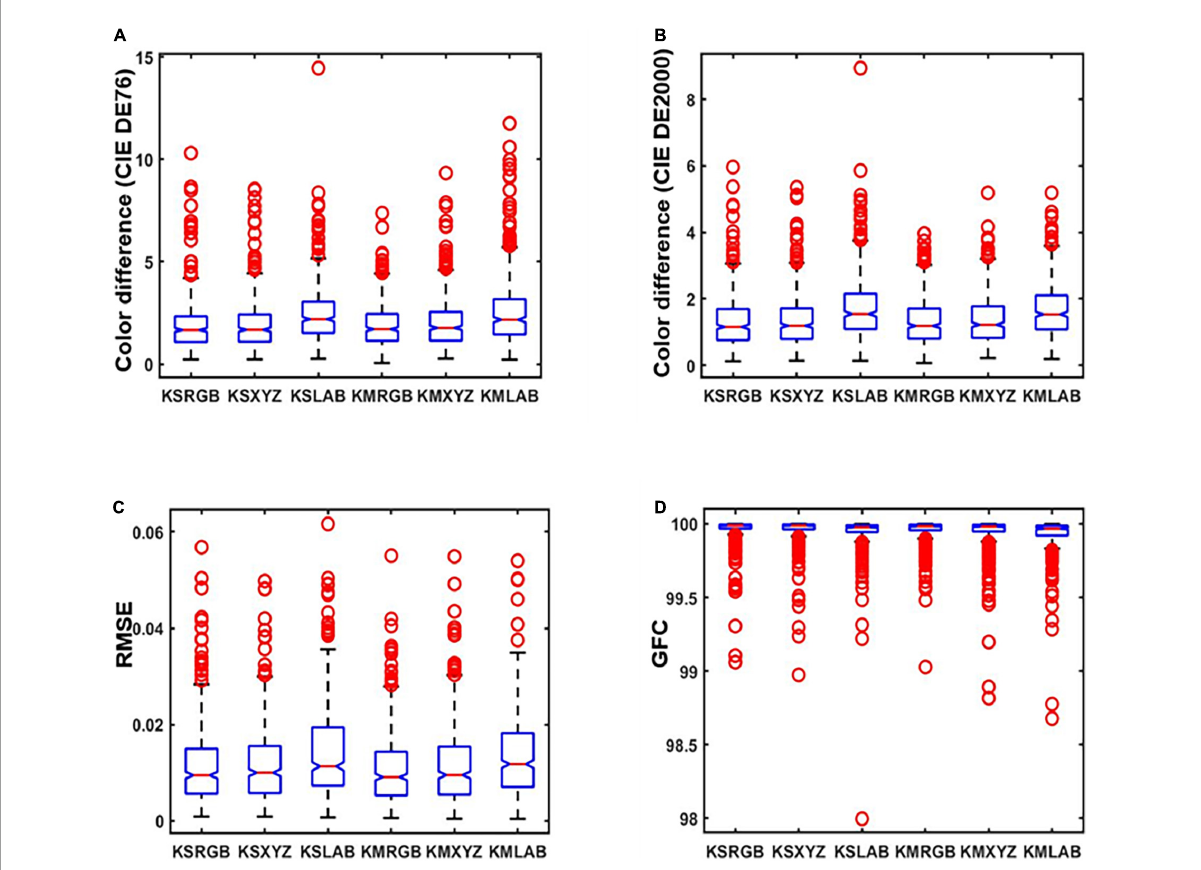
FIGURE10 Boxplots of results in different color spaces: (A) The International Commission on Illumination (CIE) DE1976 color difference, (B) CIE DE2000 color difference, (C) root-mean-square error (RMSE), and (D) goodness of fit coefficient